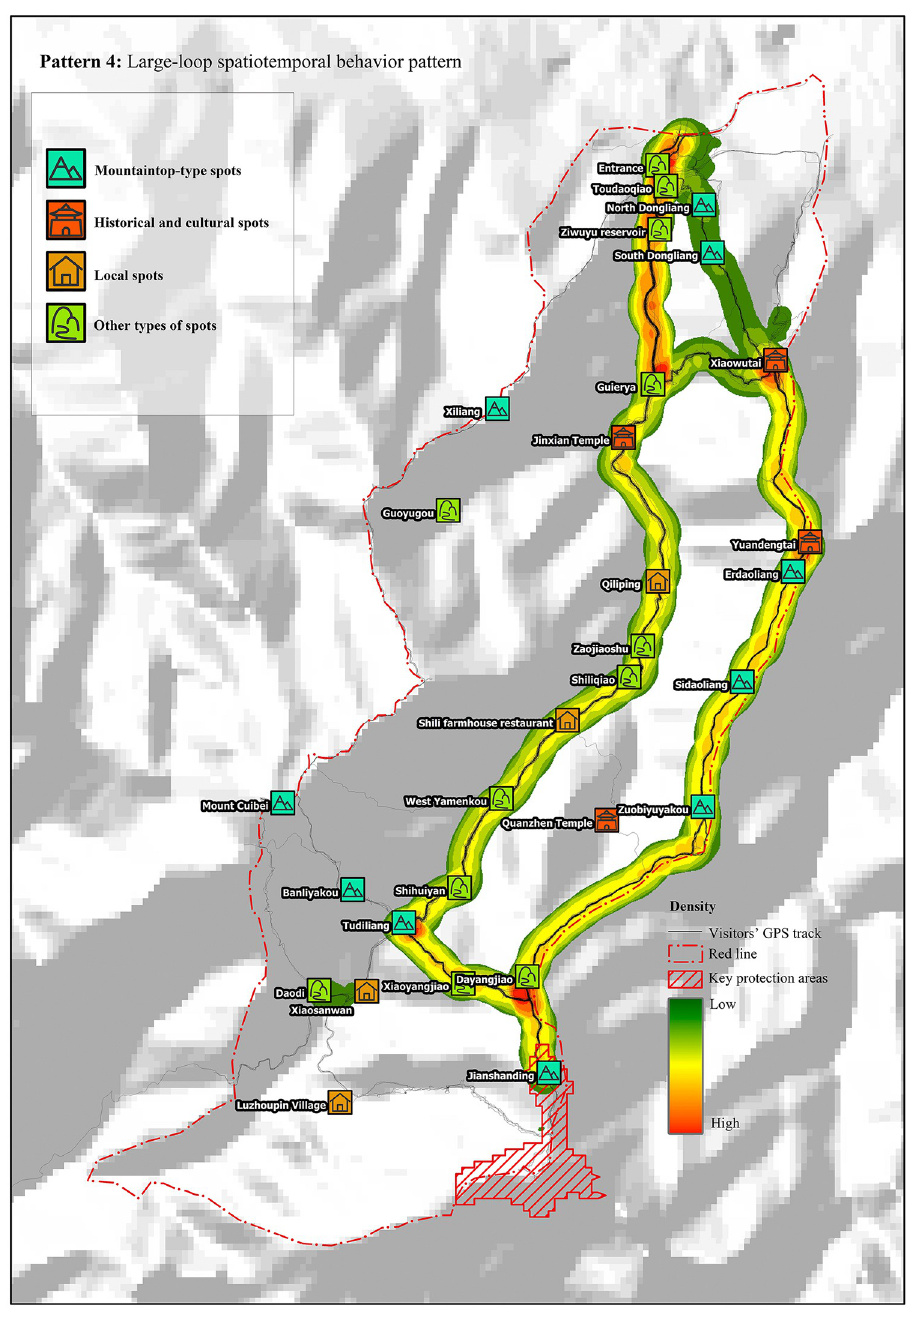
Fig 5. Large-loop spatiotemporal behavior pattern. Reprinted from [https://www.usgs.gov/centers/eros/data] under a CC BY license, with permission from [United States Geological Survey], original copyright [2000].